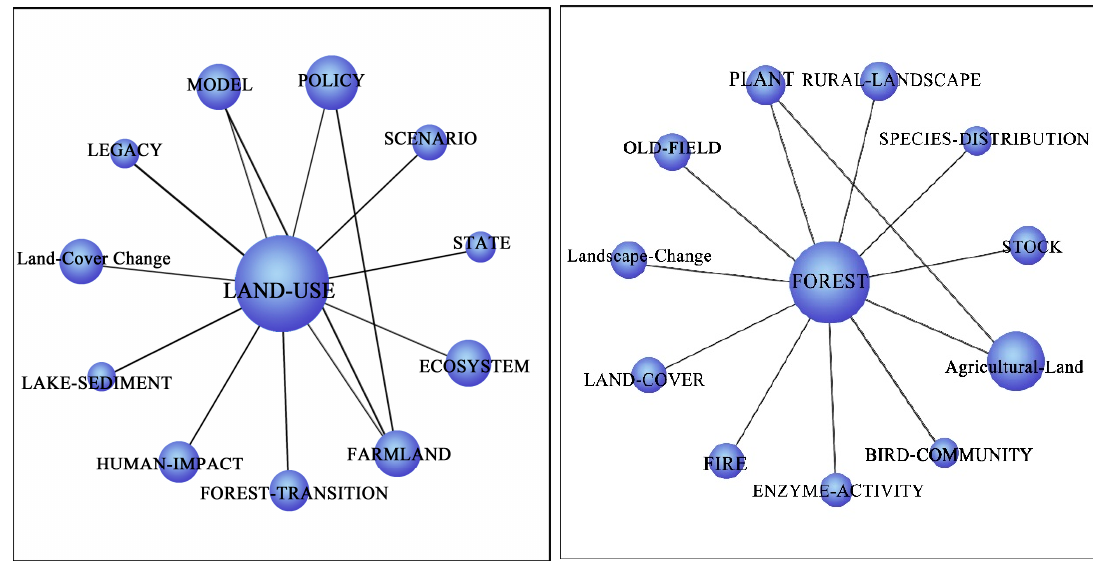
Figure 13. Land-use and forest-cluster network map.